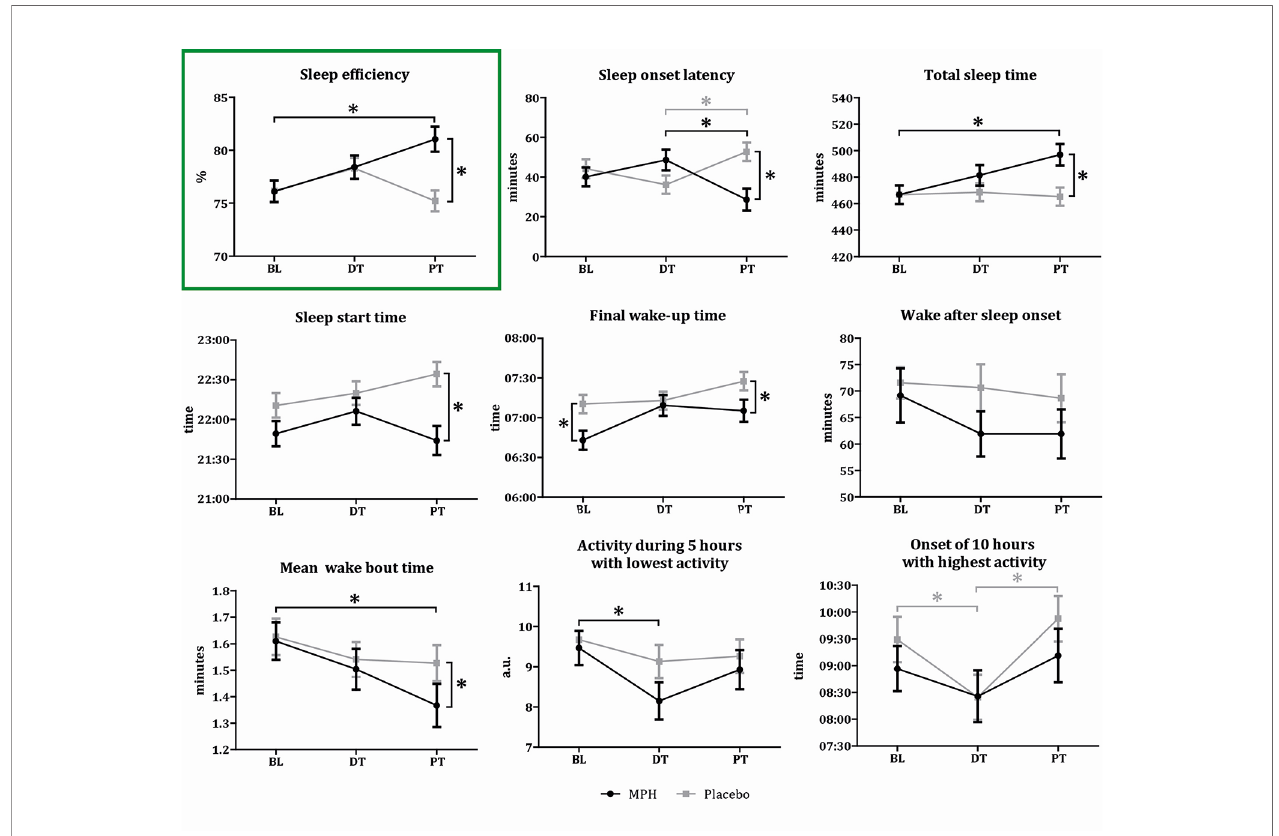
FIGURE 3 | Results sleep variables. Graphical representation of the sleep variable outcomes for the two conditions on three time points (BL, baseline; DT, during treatment; PT, post-treatment). Asterisks indicate a signi fi cant difference between the two conditions (p < 0.05). Values represent means per condition for each time point, bars represent the standard deviation. Black lines indicate the MPH treated subjects, gray lines the placebo treated